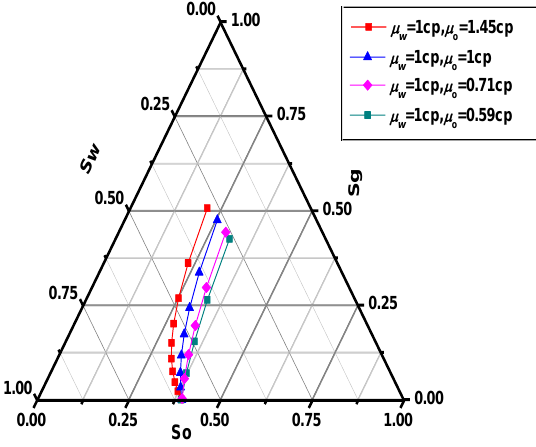
Figure 3—Oil isoperms for fracture systems with different viscosities of oil phase ( k